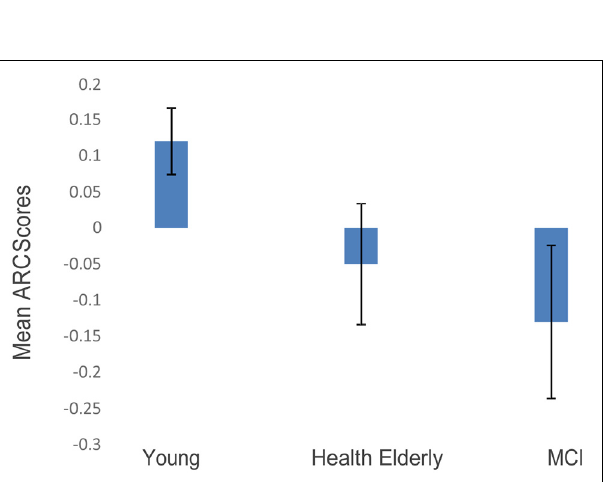
moderately-high correlation ( r = 0.62; p < 0.001). Participants